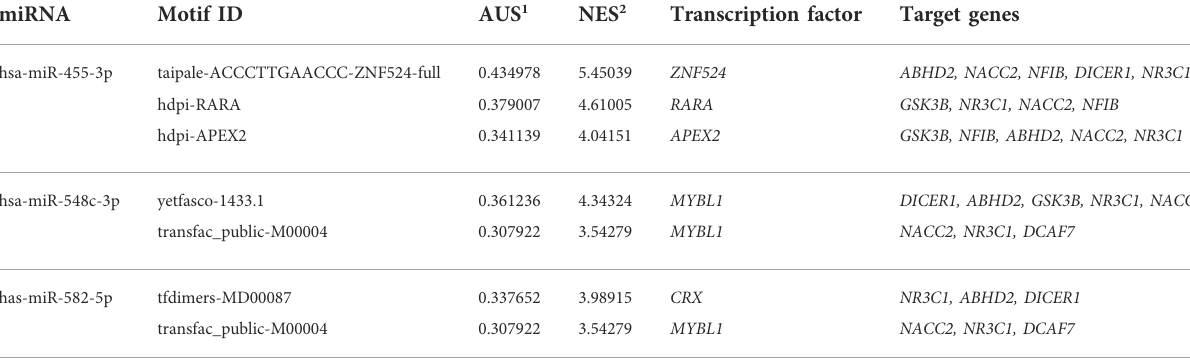
TABLE 4 The network analysis fi ndings of transcriptional factors, and their motifs with miRNA-target genes. miRNA